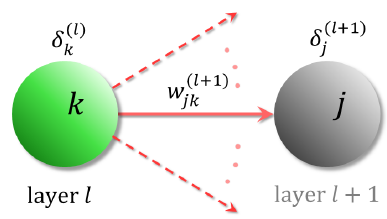
Figure 6. Back-propagation of errors. Shown here are the quantities relevant to the back-propagation of error from a neuron (solid circle) to another in the previous layer (green